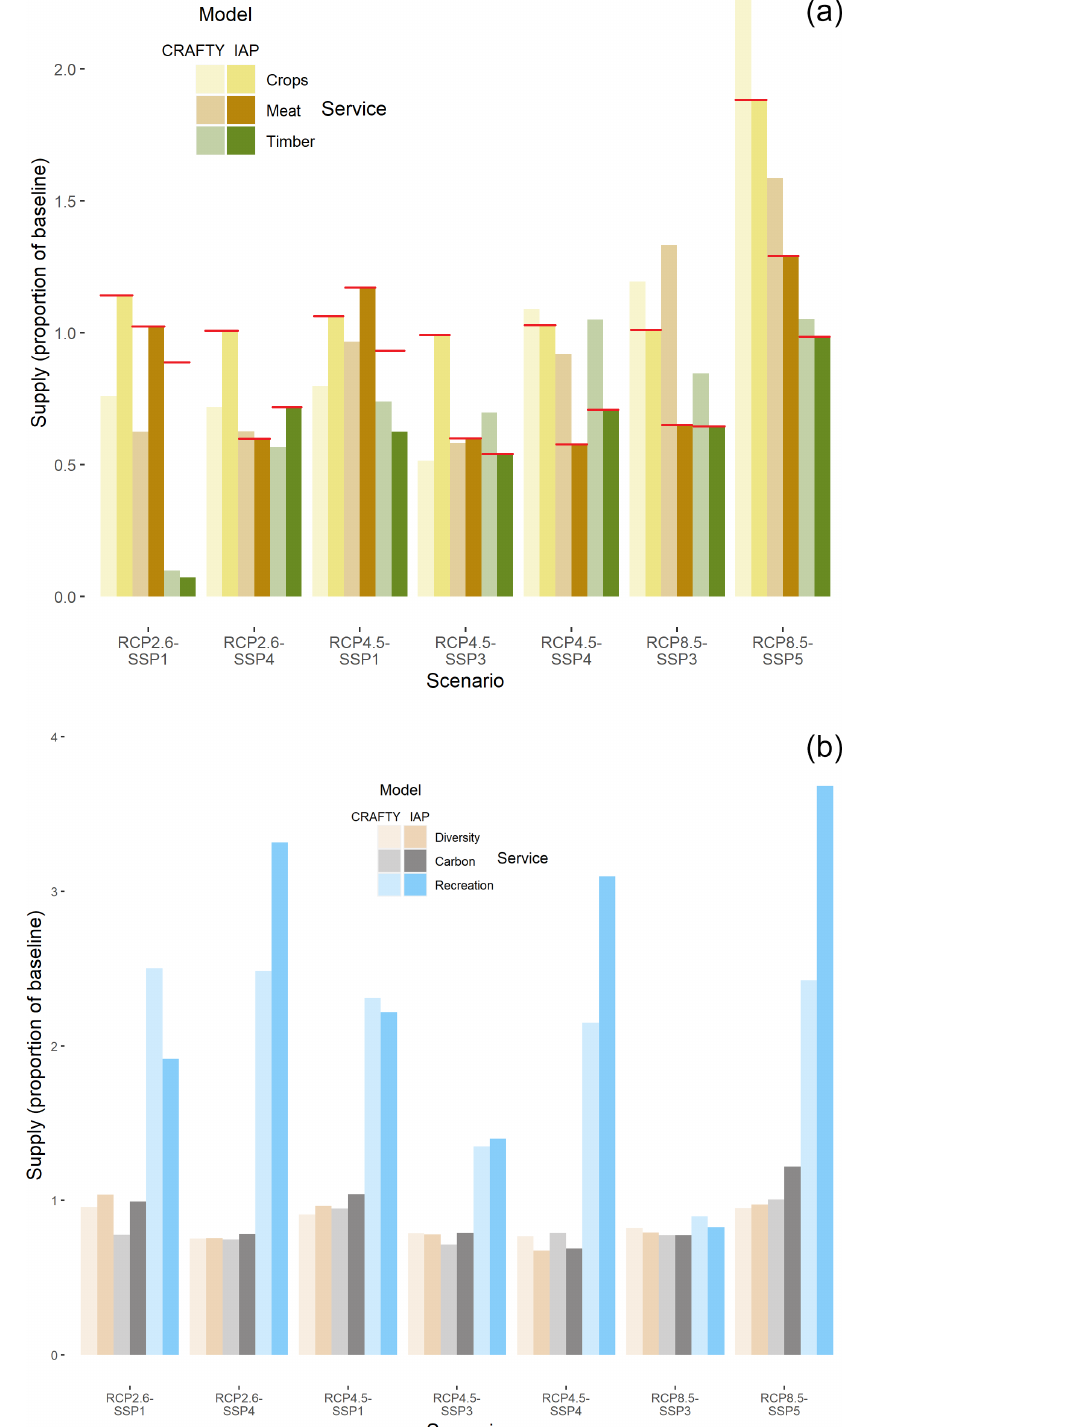
Figure 3. (a) Supply levels of services for which both models attempt to satisfy demand. Supply levels are shown for each scenario, and demand levels (derived from the IAP) are indicated by a red line for each service. IAP supplies are unequal to demand levels only where the IAP reports an underproduction of a particular service (in these results, timber in SSP1 simulations). A supply value of 1.0 ( y axis) is equal to baseline supply. (b) Supply levels of services for which only CRAFTY attempts to satisfy demands (while the IAP does not). IAP supply levels here are calculated using CRAFTY production functions and then set as demands for CRAFTY. Demand levels are therefore equal to IAP supply by default and are not indicated by a line as in (a) . A supply value of 1.0 ( y axis) is equal to baseline